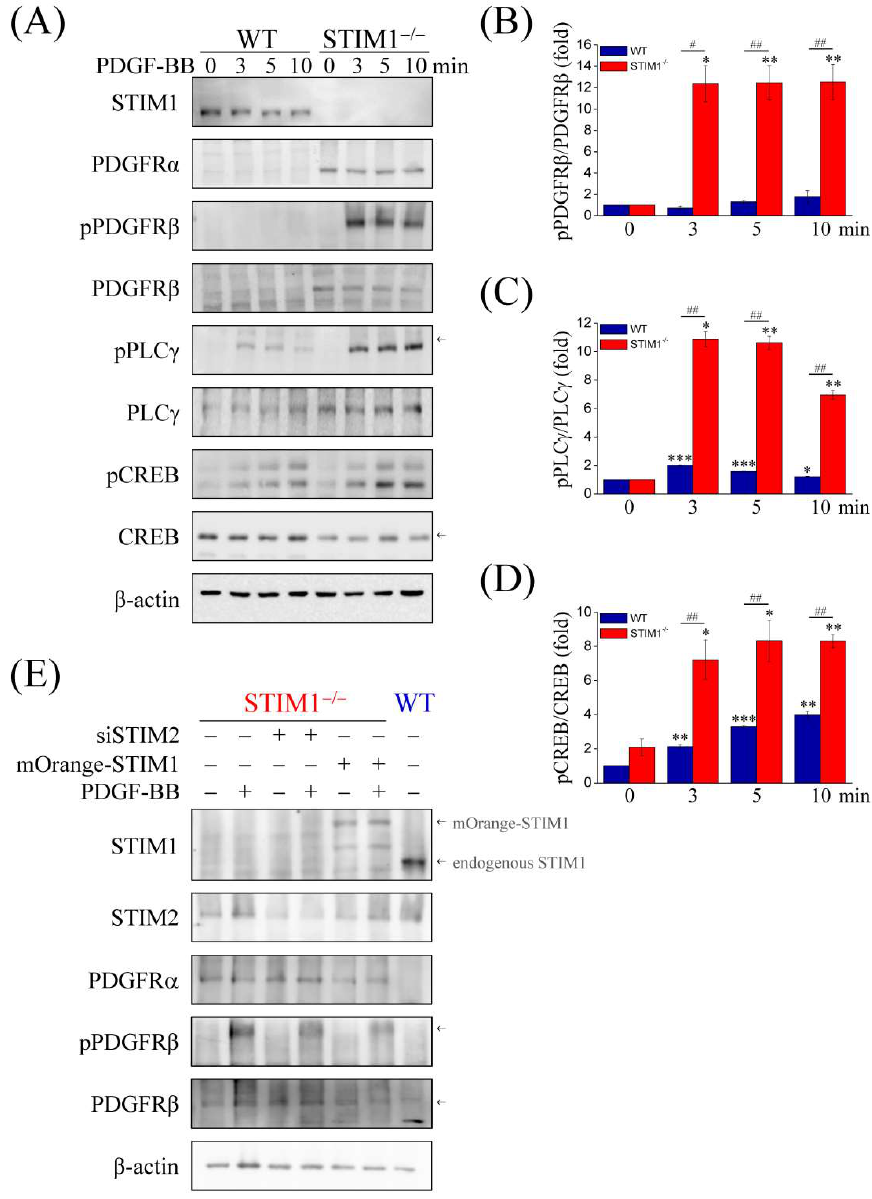
Figure 3. STIM1 knockout enhances the expression of PDGFRα and PDGFRβ, and increases phosphorylation of phospholipase C gamma (PLCγ) and cAMP response element binding protein (CREB). ( A ) MEF-WT and MEF-STIM1 −/− cells were starved in a serum-free medium for 12 h and then stimulated with 100 ng/mL PDGF-BB for 3, 5, and 10 min. Immunoblotting analysis using antibodies against STIM1, PDGFRα, phospho-PDGFRβ (pPDGFRβ), PDGFRβ, phospho-PLCγ (pPLCγ), PLCγ, phospho-CREB (CREB), and CREB. β-actin served as the internal control; ( B – D ) Measurement of the relative intensities of protein phosphorylation are represented as mean ± SEM from three independent experiments for both MEF-WT and MEF-STIM1 −/− cells. Bar charts show phosphorylation levels of ( B ) pPDGFRβ, ( C ) pPLCγ, and ( D ) pCREB, which were normalized to the total protein. *,#: p < 0.05; **,##: p < 0.01; ***: p < 0.001 by Student’s t -test; ( E ) Knockdown of STIM2 or overexpression of STIM1 upon transient transfection with STIM2 siRNA (siSTIM2) and mOrange-tagged STIM1 plasmid (mOrange-STIM1) for 48 h in MEF-STIM1 −/− cells, respectively. Cells were starved in a serum-free medium for 12 h and then stimulated with or without 100 ng/mL PDGF-BB for 5 min. Immunoblotting analysis using antibodies against STIM1, STIM2, PDGFRα, phospho-PDGFRβ, and PDGFRβ. β-actin served as the internal control. The MEF-WT cells were used as a control for MEF-STIM1 −/− cells. Arrows indicate the target proteins.